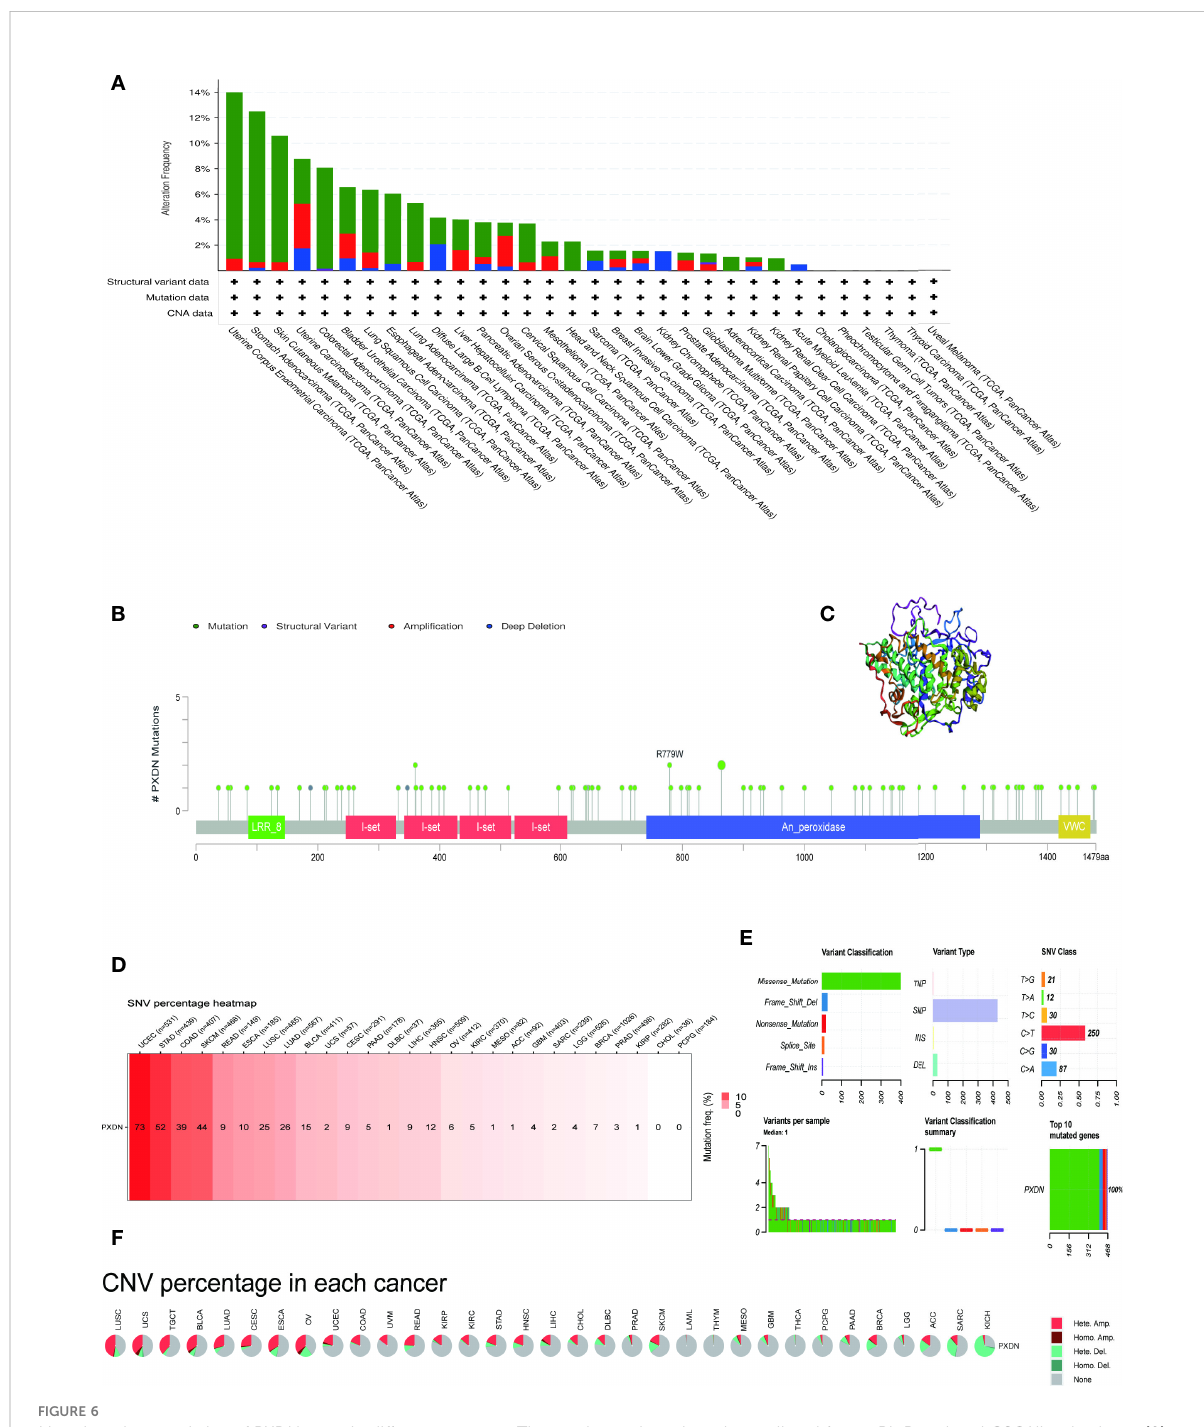
FIGURE 6 Mutation characteristics of PXDN gene in different tumours. The results are based on data collated from cBioPortal and GSCAlite database. (A) Types of mutations of PXDN in different tumours. (B) Frequency of PXDN mutation in different tumours. (C) Display the 3D structure of PXDN. (D) Frequency of SNV in 27 cancer types. (E) (A) Top left (variant classi fi cation): count of each type of deleterious mutation (missense mutation, nonsense mutation, frame shift ins, splice site, frame shift del, in frame del, in frame ins) of PXDN in different tumors. Top middle (variant type): count of the SNP and DEL of PXDN in different tumors. Top right (SNV class): count of each SNV class of PXDN in different tumors. Down left (variants per sample): count of variants in each sample. A bar indicates a sample, and the color of the bar corresponds to the color of the variant classi fi cation. Down middle (variant classi fi cation summary): the distribution of the count of each variant classi fi cation in the sample set of different tumors. The color of the box corresponds to the color of the variant classi fi cation. Down right (top 10 mutated genes): count and percentage of variants in the top 10 mutated genes. (F) CNV of PXDN in the 33 cancer